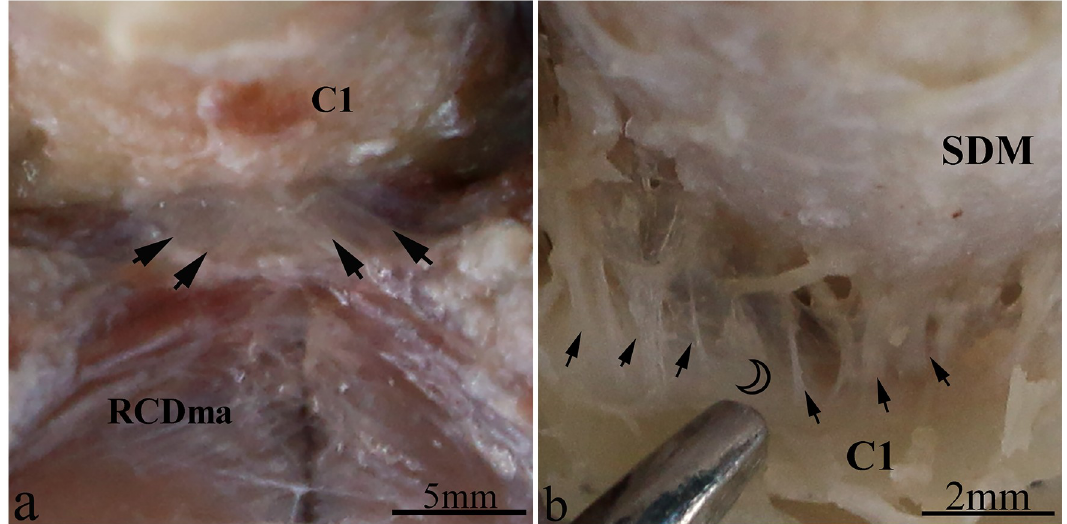
Fig 2. Gentoo penguin, dorsal views of an anatomical dissection of the Atlanto-axial interspace. a: The connection between the RCDma and the dorsal atlanto-axial membrane. The ventral surface of RCDma is connected by dense fibrous bundles (arrow) to the dorsal atlanto-axial membrane. b: The connection between the dorsal atlanto-axial membrane and the SDM. The dorsal atlanto-axial membrane was separated from its posterior arch of atlas, and the ventral surface of the dorsal atlanto-axial membrane is connected by dense cord-like fibrous tissues (arrow) to the SDM (hollow crescent). Abbreviation: RCDmi = rectus capitis dorsalis minor muscle; RCDma = rectus capitis dorsalis major muscle; SDM = spinal dura mater; C1 = posterior arch of